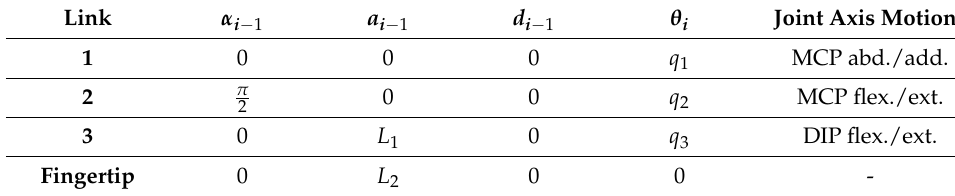
Table 2. Modified DH parameters for